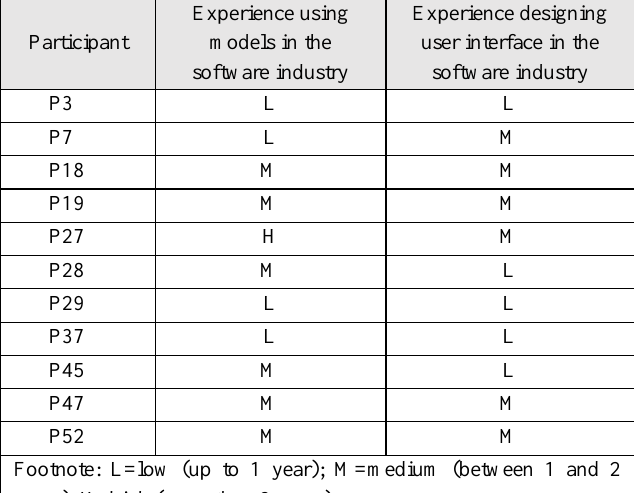
TABLE I. C HARACTERIZATION OF D ESIGNERS ’ Y EARS OF E XPERIENCE .